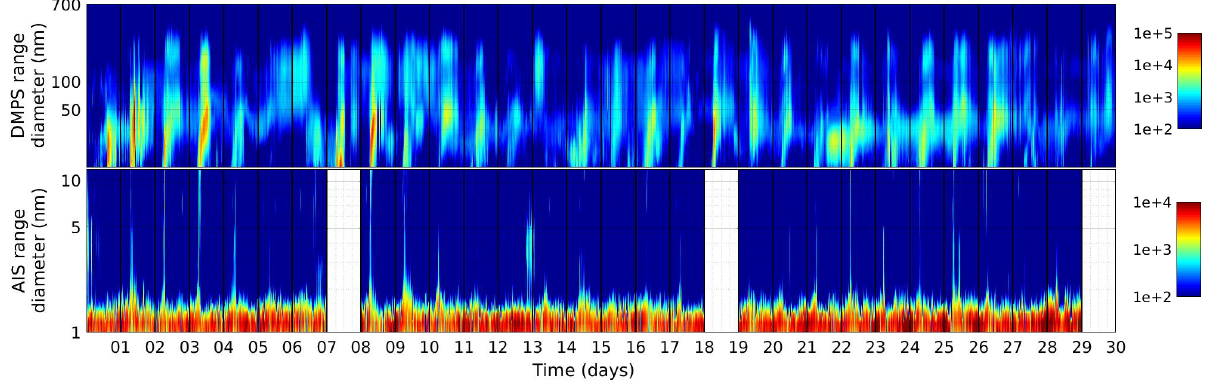
Figure A6. DMPS and AIS spectra for June 2015. We can see that 8th, 19th, and 30th June were not available because of missing